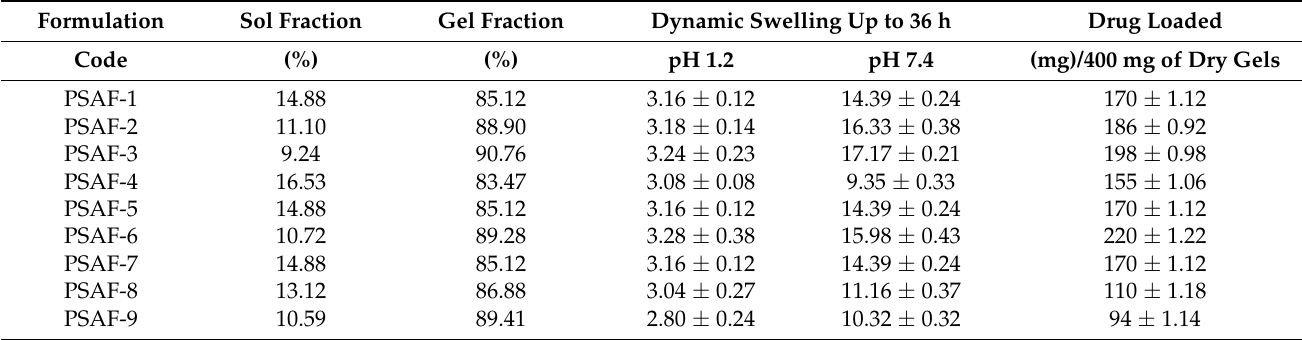
Table 1. Sol-gel analysis, dynamic swelling, and drug loading of sodium poly(styrene sulfonate-co-poly acrylic acid (SPSPAA)